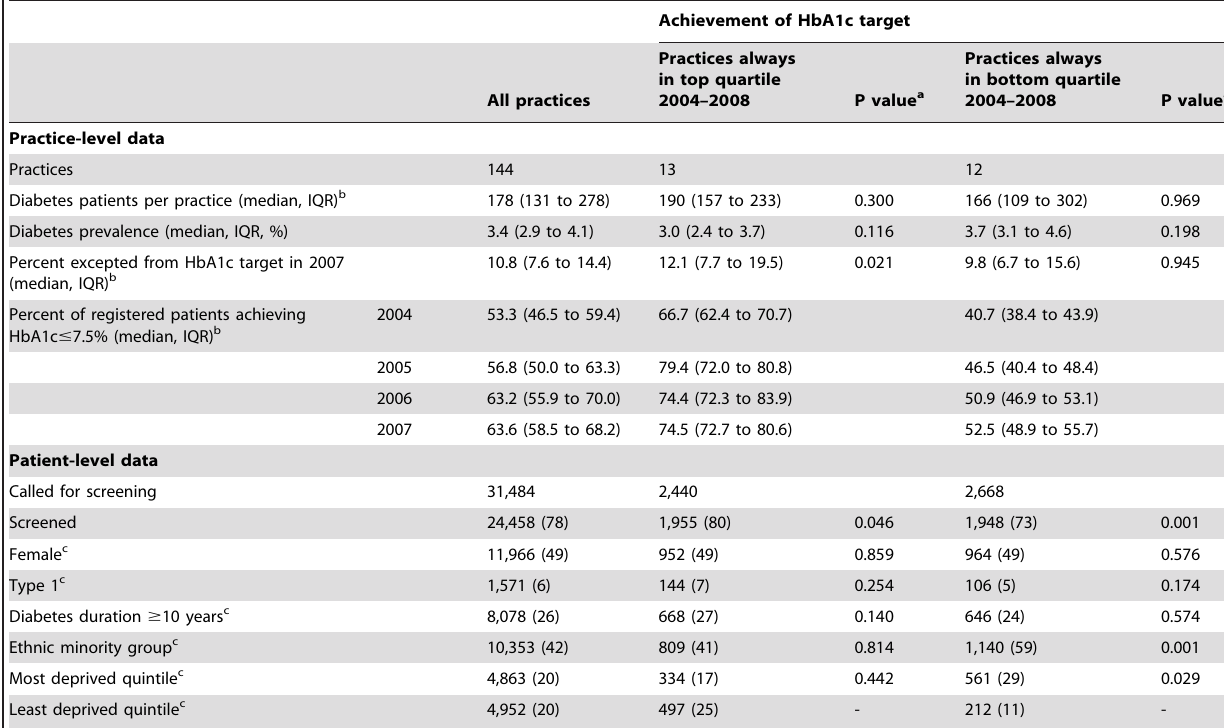
Table 1. Characteristics of participants according to pay-for-performance